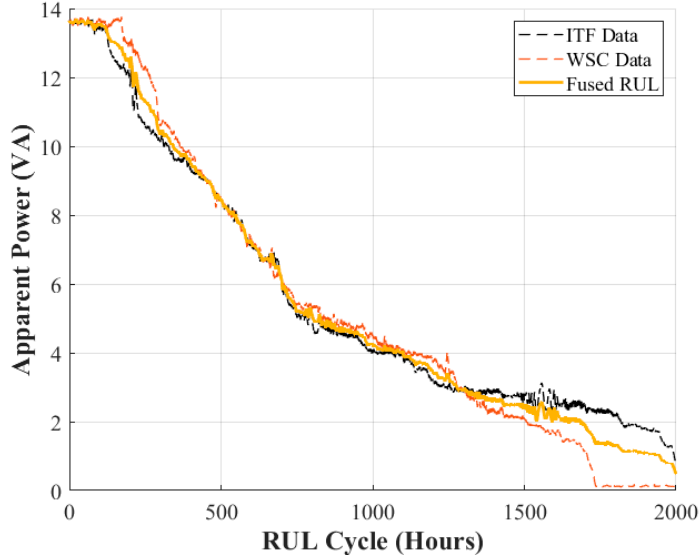
Figure 13. RUL estimation from ITF and WSC degradation data.